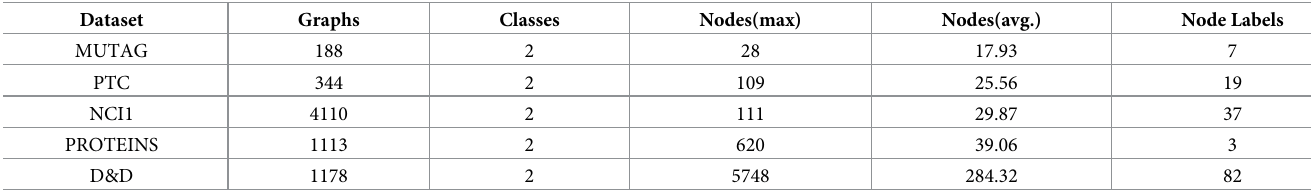
Table 6. Common datasets for graph classification